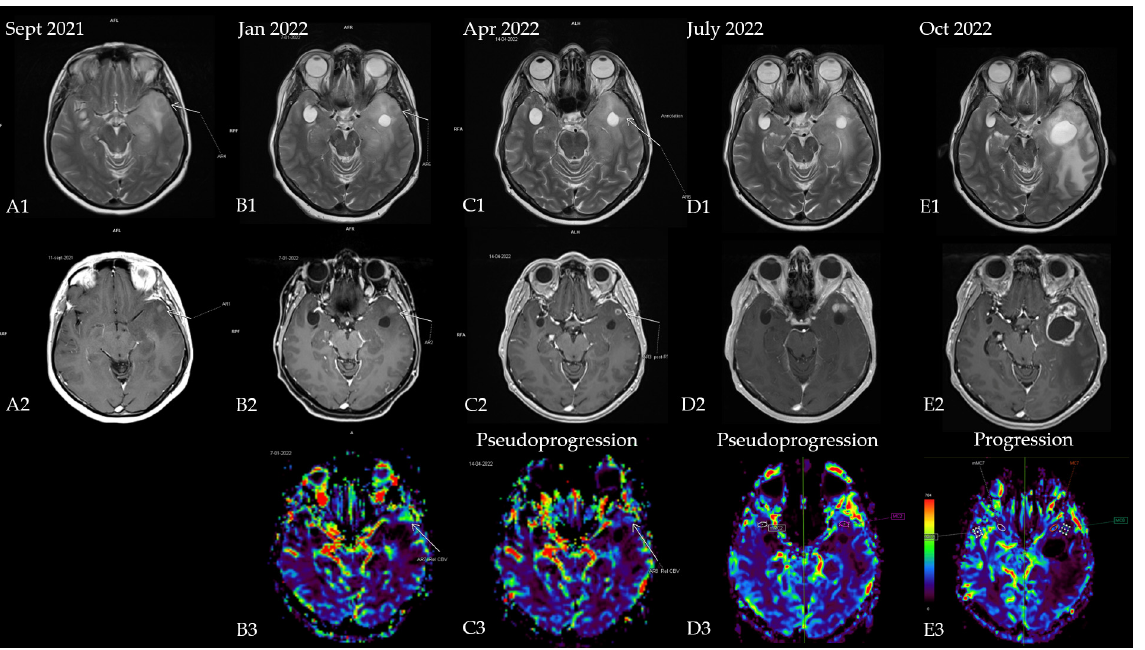
Figure 1. Patient’s disease progression showcased through serial brain MRI imaging. ( A ) Brain MRI at diagnosis (( A1 )—T2 sequence showing diffuse hypersignal in the left temporal lobe; ( A2 )—T1 + contrast showing a slight nodular enhancement located in the anterior part of the temporal); ( B ) brain MRI after completion of the first PCV cycle (( B1 )—T2 sequence with nodular hypersignal with CSF-like signal from the biopsy site; ( B2 )—T1 + contrast showing a slight increase in the size of the contrast-enhancing nodule; ( B3 )—postprocessing rCBV (relative cerebral blood volume) image showing hyperperfusion within the left temporal lobe). Results of the NGS testing corrected the initial diagnosis, and chemoradiotherapy was initiated. ( C ) Brain MRI 4 weeks after chemoradiotherapy (( C1 )—T2 sequence showing mild reduction of the hypersignal; ( C2 )—T1 + contrast showing a nodular lesion with ring-shaped contrast enhancement with intralesional necrosis; ( C3 )—rCBV postprocessing showing reduction in perfusion in the enhancing area); ( D ) brain MRI showing pseudo-progression (3 months after starting TMZ and 4 months after completion of radiotherapy) (( D1 )—T2 sequence showing mild reduction of the hypersignal; ( D2 )— T1 + contrast showing 2 nodular lesions with contrast enhancement; ( D3 )—rCBV postprocessing showing complete decrease in perfusion in the enhancing area); ( E ) brain MRI from October 2022 (1 month after she finished 6 cycles of TMZ and 7 months after radiotherapy completion) showing disease progression (( E1 )—T2 sequence showing enhanced hypersignal and significant mass effect of a new lesion in the anterior temporal lobe with perilesional edema; ( E2 )—T1 + contrast showing a cystic lesion with ring-shaped contrast enhancement with intralesional necrosis and new extension within the anterior part of the temporal lobe; ( E3 )—rCBV postprocessing heatmap showing no apparent signs of hyperperfusion).